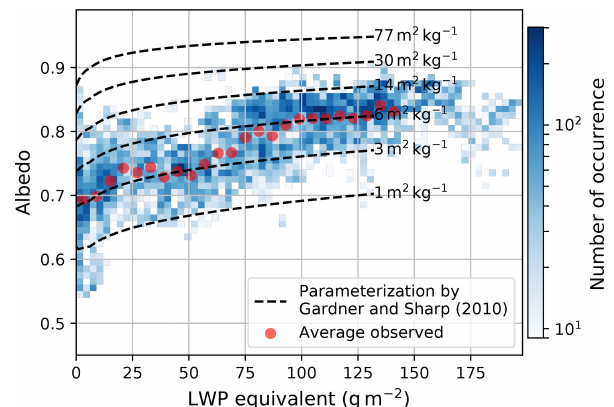
Figure 9. Histogram of shortwave, longwave, and total (cid:49)F derived during the cloud-free ACLOUD flight on 25 June 2017. Statistics are given in the gray box (mean ∅ , standard deviation σ